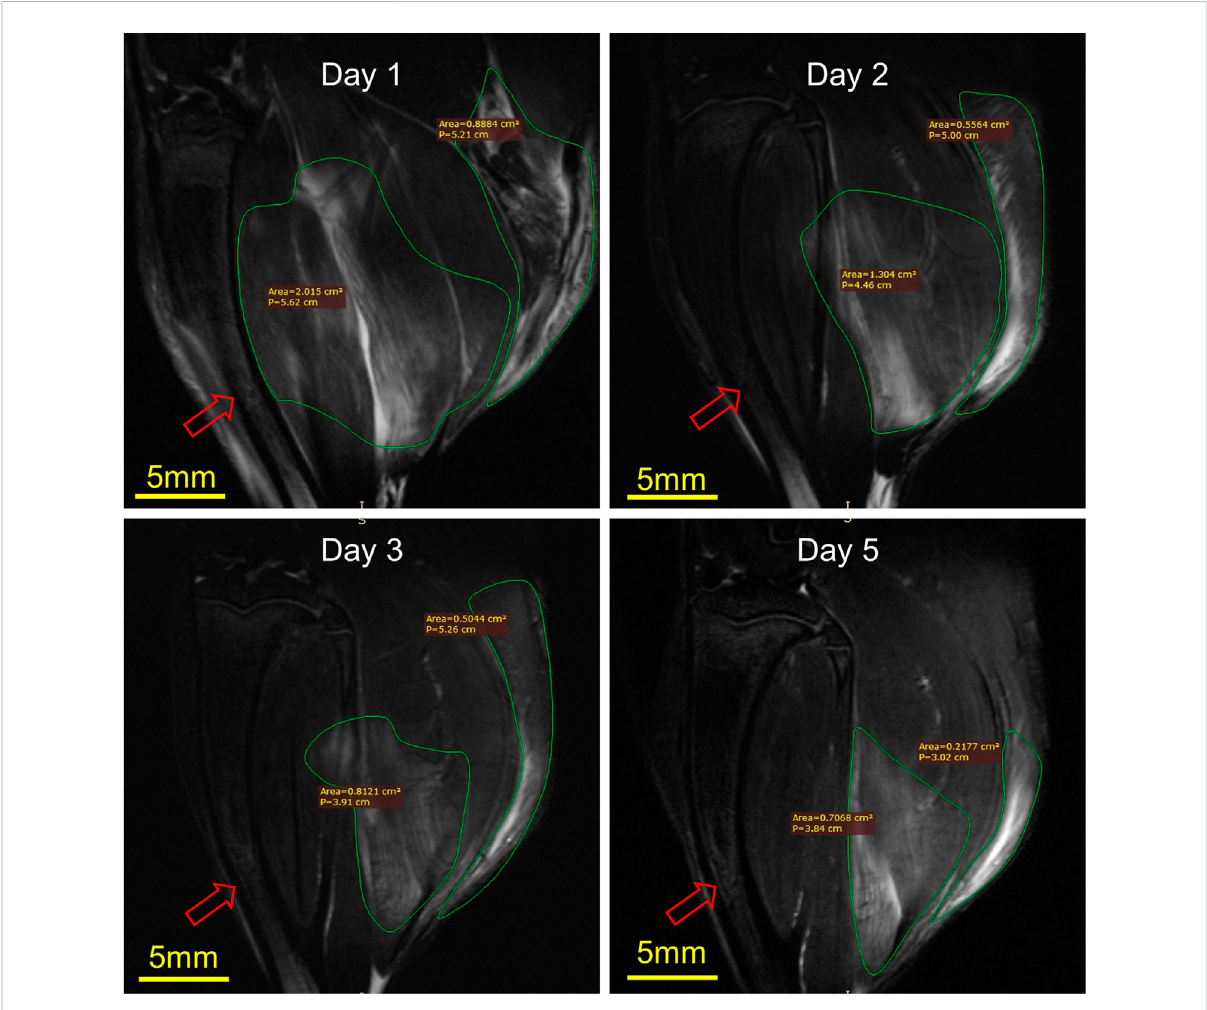
FIGURE 6 Representative MRI of rat RH limbs at different times after the injury ( n = 4). Scale bar = 5 mm. The same tibial (red arrow) plane of the same rat was selected for observation. On the fi rst day, the areas of muscle edema and subcutaneous edema were 2.015 cm 2 and 0.89 cm 2 , respectively,